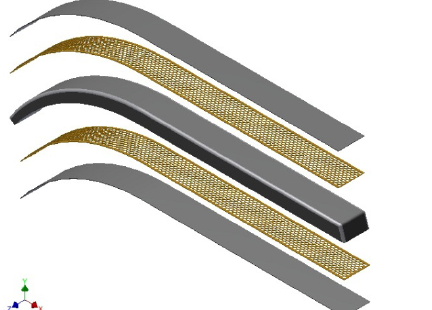
Figure 11: Architecture of the SMA//GFRP hybrid composite horn. Grey [-45/+45] n layered GFRP host composite. Brown: Embedded CuZnAl SMA thin patterned sheets.